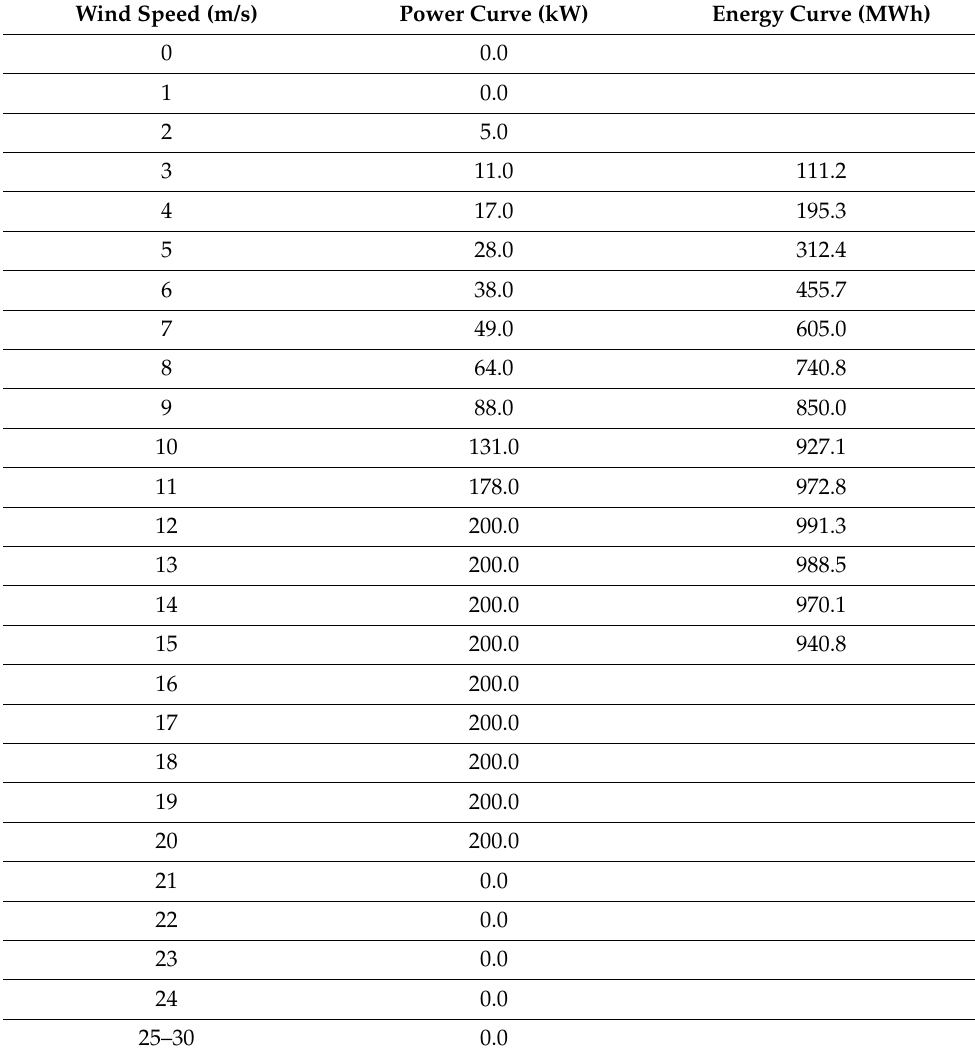
Table 20. Power curves and wind turbine energy curve